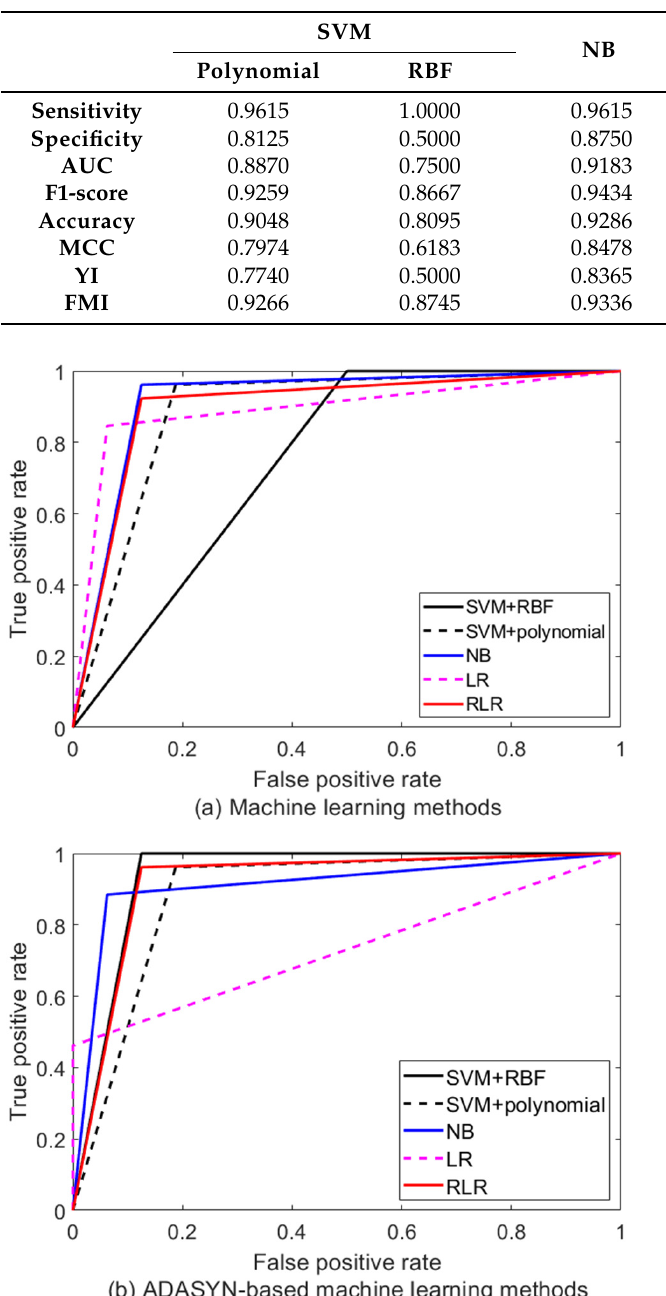
Table 3. Performance comparison of SVM with different kernel functions, NB, LR, and RLR trained based on an imbalanced seismic dataset.